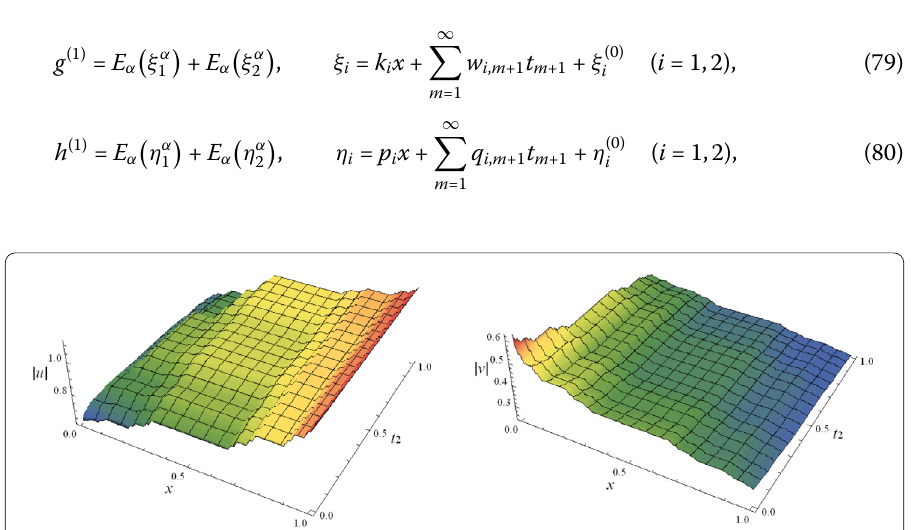
Figure 1 Space-time structures of one-fractal solutions (78) with α = ln2/ln3.